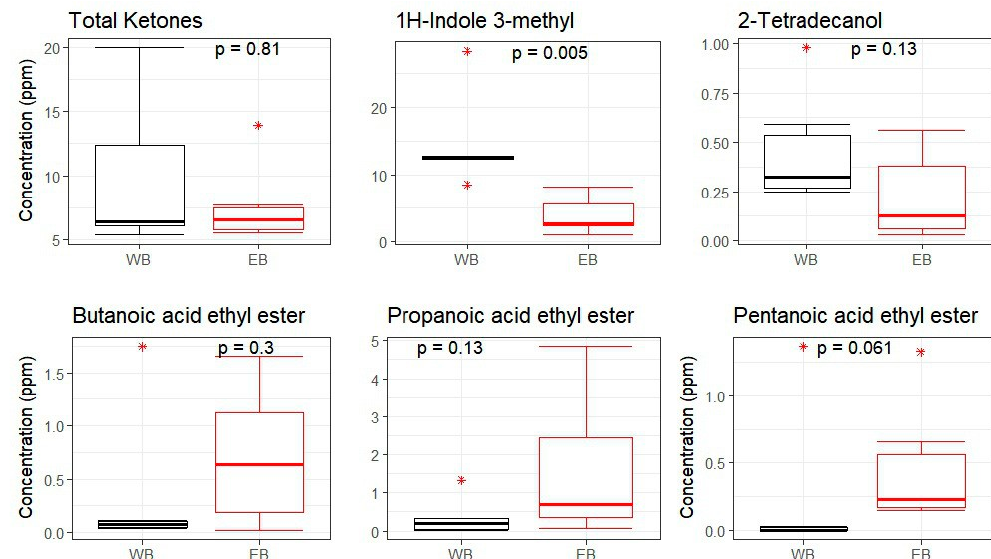
Figure 7. Boxplots showing the concentrations of the main fecal volatile molecules, analyzed by GC- MS, discriminating between t0 (blue) and t30 (orange) in the einkorn (EB; Figure 7 A ) and wheat (WB; Figure 7 B ) bread-based diet groups, as determined through Random Forest. *, outliers. p values were determined by Wilcoxon test.